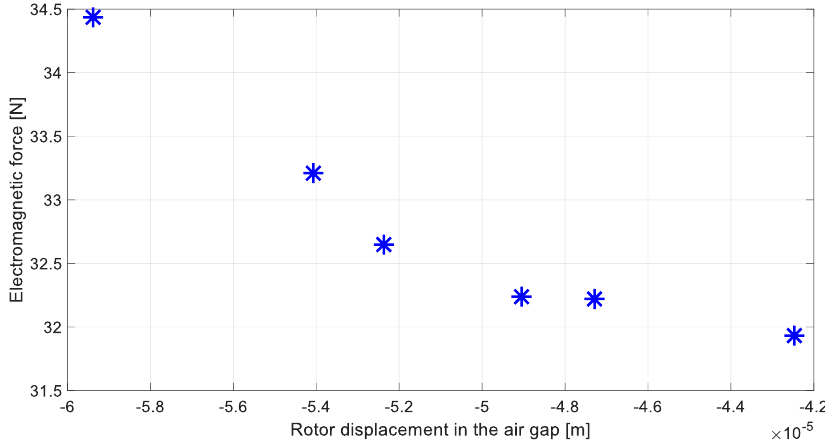
Figure 19. The resultant electromagnetic force generated by the magnetic bearing for different displacements of the rotor–shaft raceway.